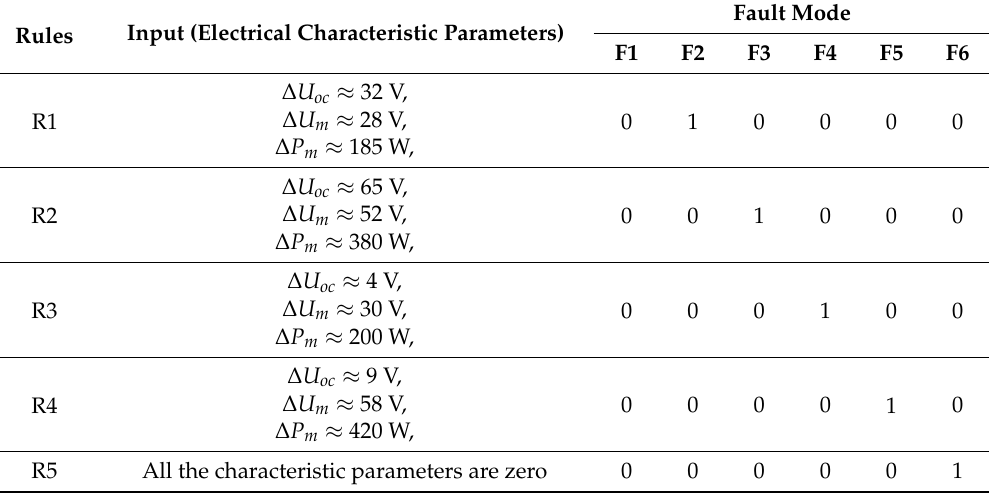
Table 4. Cluster center rules under different fault